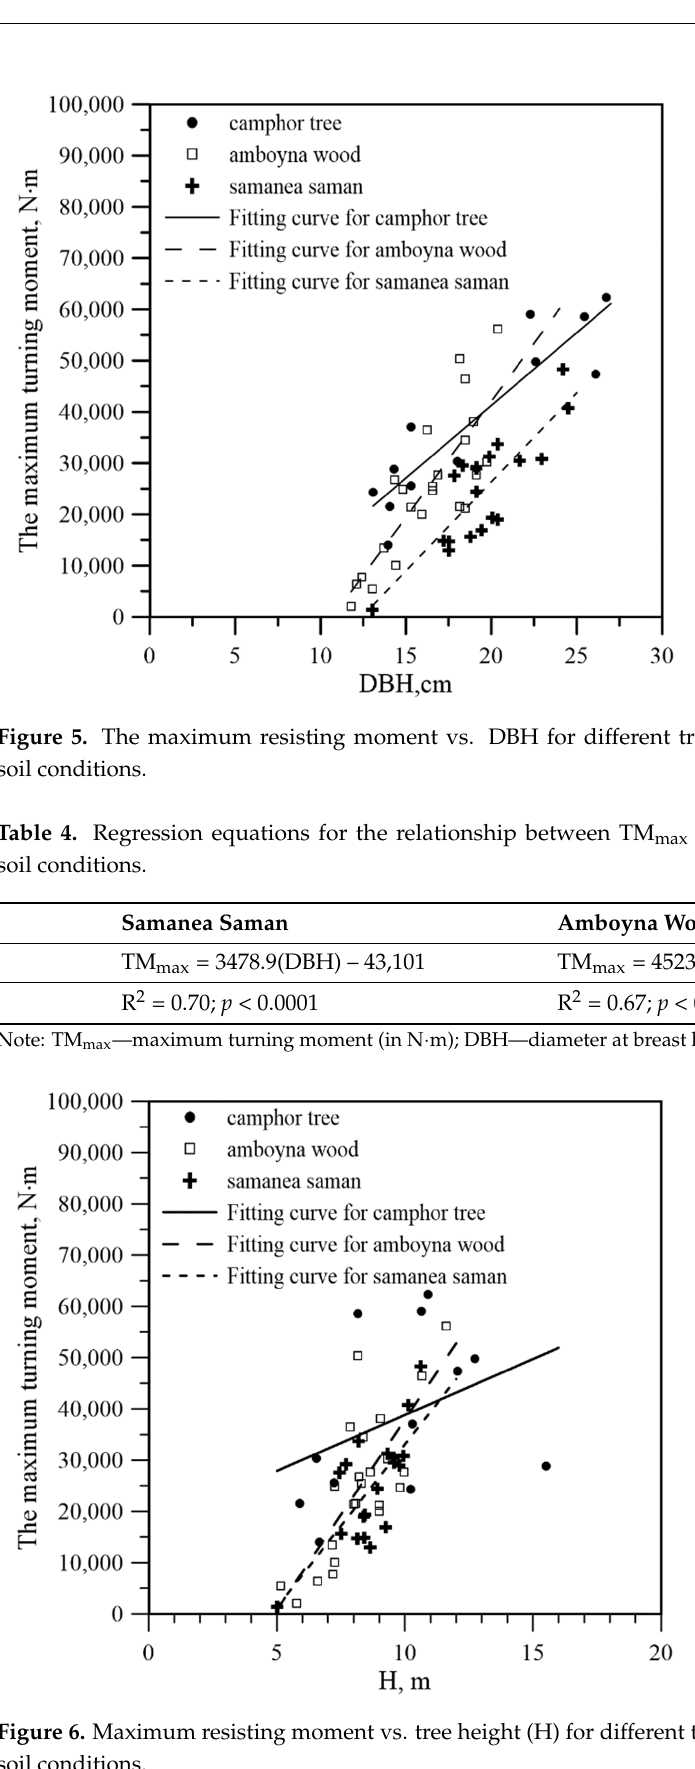
Figure 6. Maximum resisting moment vs. tree height (H) for different tree species in near-saturated soil conditions.